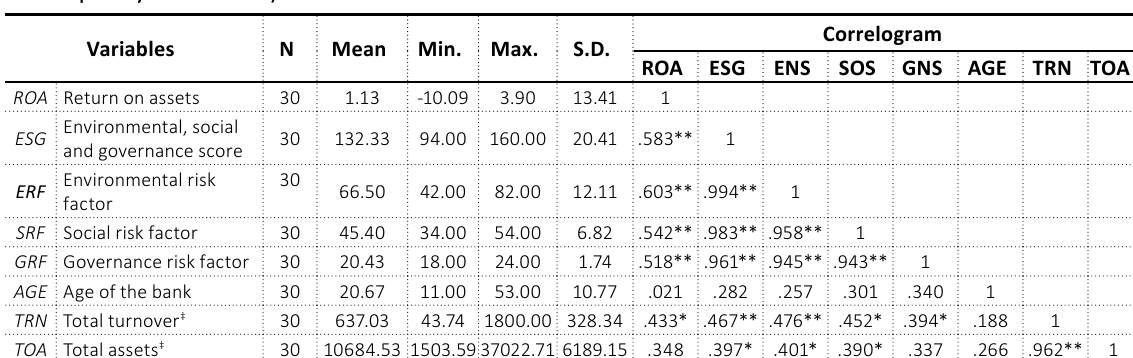
Table 3. Descriptive statistics and Pearson correlations (2012) (reproduced with permission from Specify the